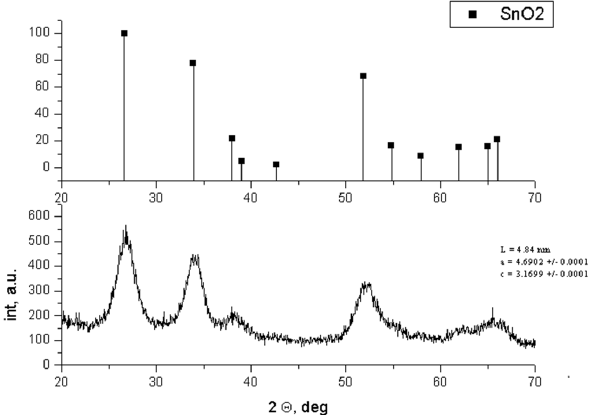
Figure 2. Diffractogram of the system SnO 2 /V 2 O 5 /La 2 O 3